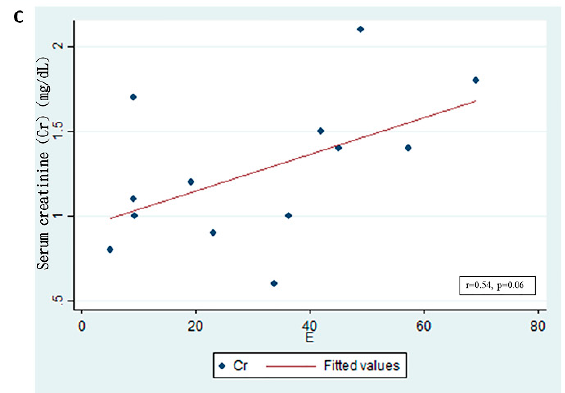
Figure 7. Low-density lipoprotein (LDL) levels and graft kidney lipid accumulation/fibrosis in patients who received kidney transplantation. ( n = 18) ( A ) Serum LDL significantly, positively correlated with fibrosis in the graft kidneys, as shown by E (kidney stiffness) (r = 0.64, p = 0.02). ( B ) Serum LDL significantly, positively correlated with lipid accumulation in the graft kidneys. The controlled attenuation parameter (CAP) (r = 0.06, p = 0.05) is shown. ( C ) Serum creatinine (Cr, mg/dL) positively correlated with fibrosis in graft kidneys, as shown by E (r = 0.54, p = 0.06).